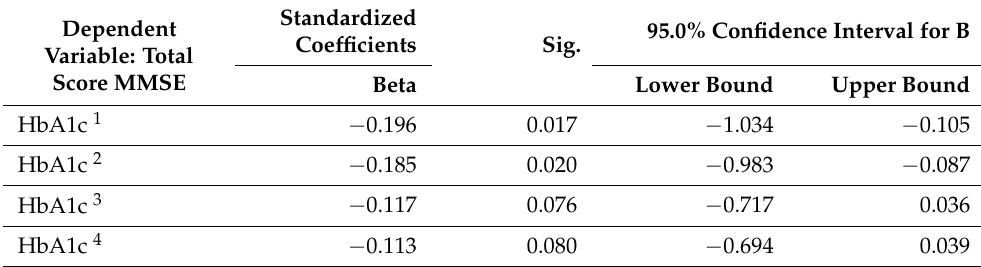
Table 8. HbA1c as a predictor of the MMSE total score.